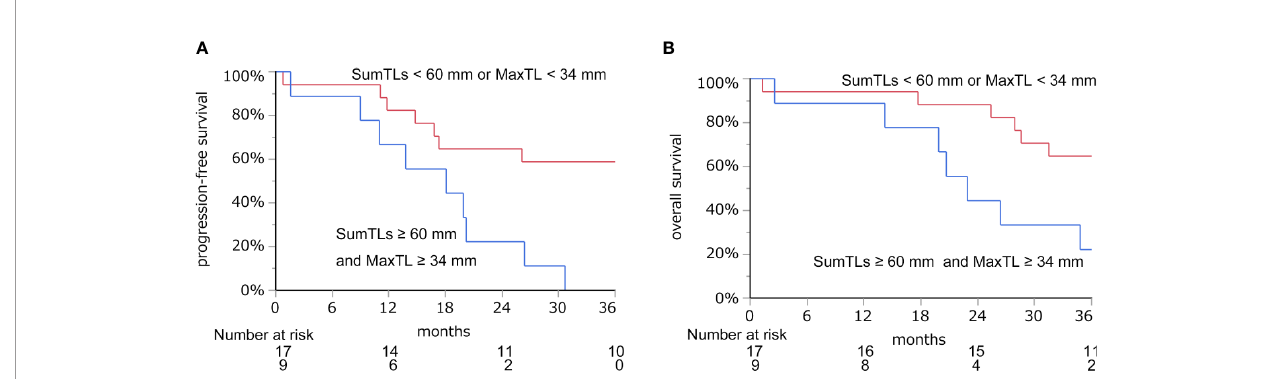
FIGURE 3 | Progression-free survival (A) and overall survival (B) based on the cut-off value of SumTLs and MaxTL. Kaplan-Meier estimate of PFS and OS strati fi ed by baseline tumor burden among patients treated with lenvatinib. MaxTL, the maximum tumor diameter of target lesion; SumTLs, the sum of diameters of target